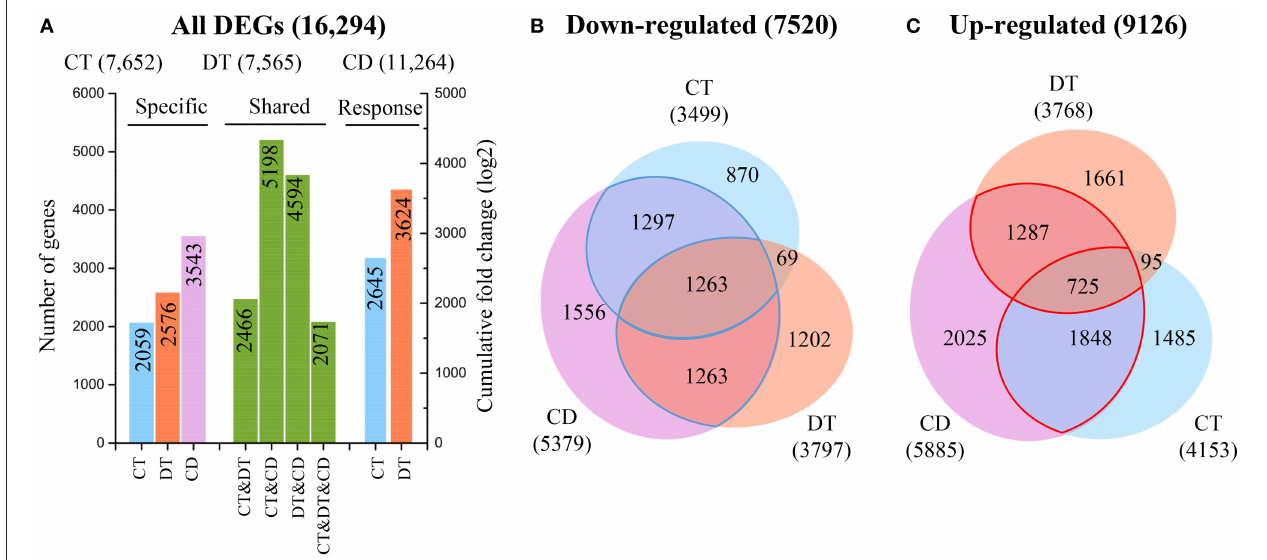
FIGURE 2 | Relationships between transcriptome responses during CT, DT, and CD. (A) The histogram showing the number of common and specific DEGs during CT, DT, and CD (left), and the cumulative log-fold changes of 1000 most significantly CT- and DT-responding unigenes in CD (right), respectively. Venn diagram of genes (B) down-regulated or (C) up-regulated by each stress. The numbers of common and specific DEGs were shown in the overlapping and non-overlapping regions, respectively. The total numbers of up- and down-regulated DEGs were indicated in parentheses.